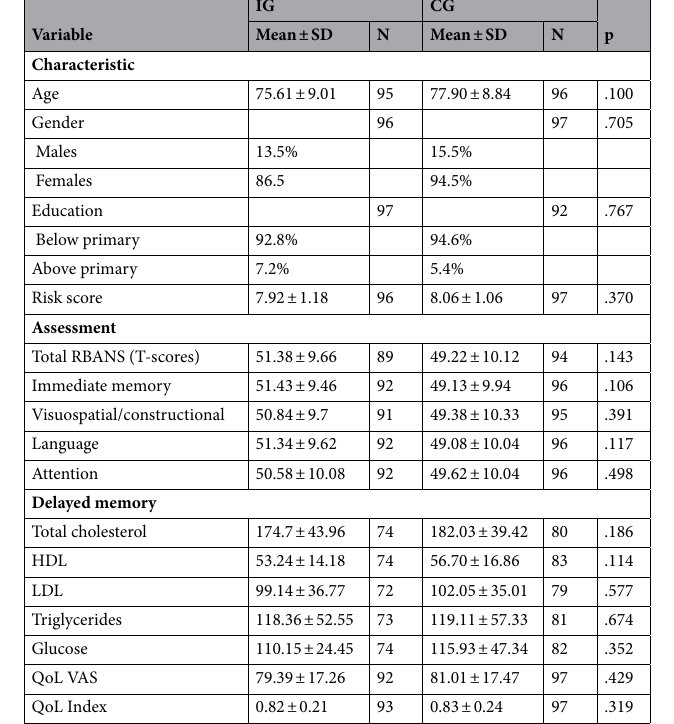
Table 3. Baseline characteristics of the participants. P value indicates statistical difference between Intervention Group (IG) and Control Group (CG). Blood test unit of measure are in mg/dL.